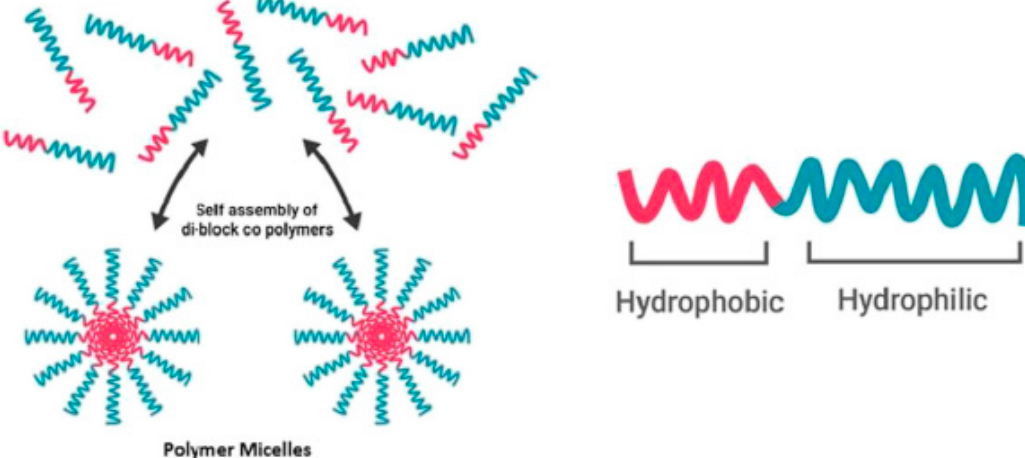
Figure 1. Above the critical aggregation concentration, amphiphilic block copolymers self-assemble into a micellular structure (adapted from Reference [8] with permission from Elsevier).